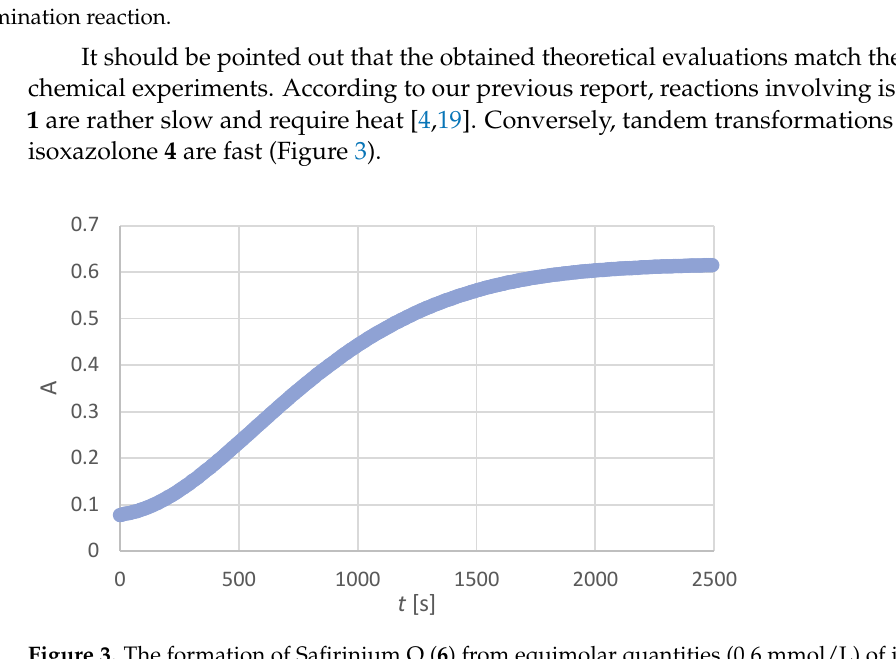
Figure 3. The formation of Safirinium Q ( 6 ) from equimolar quantities (0.6 mmol/L) of isoxazolone 4 , formaldehyde and diethylamine (absorbance at 370 nm vs. time).